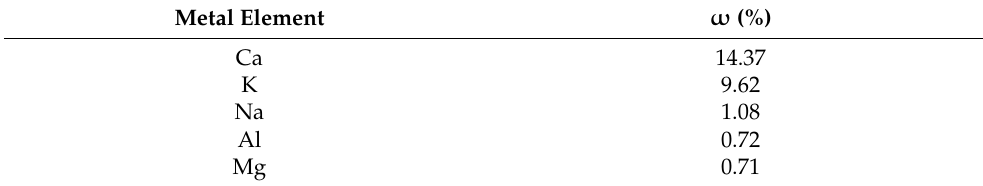
Table 2. Main metal element ingredients of the waste incineration fly